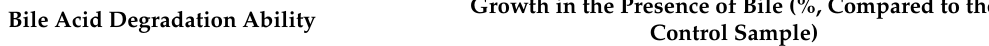
Table 4. The survival of LAB isolates of Abadeh (Fars) and Kalat (Razavi Khorasan) kashk samples in the presence of different concentrations of bile (0.3%, 0.5%, and 1%), and their ability for the degradation of different bile